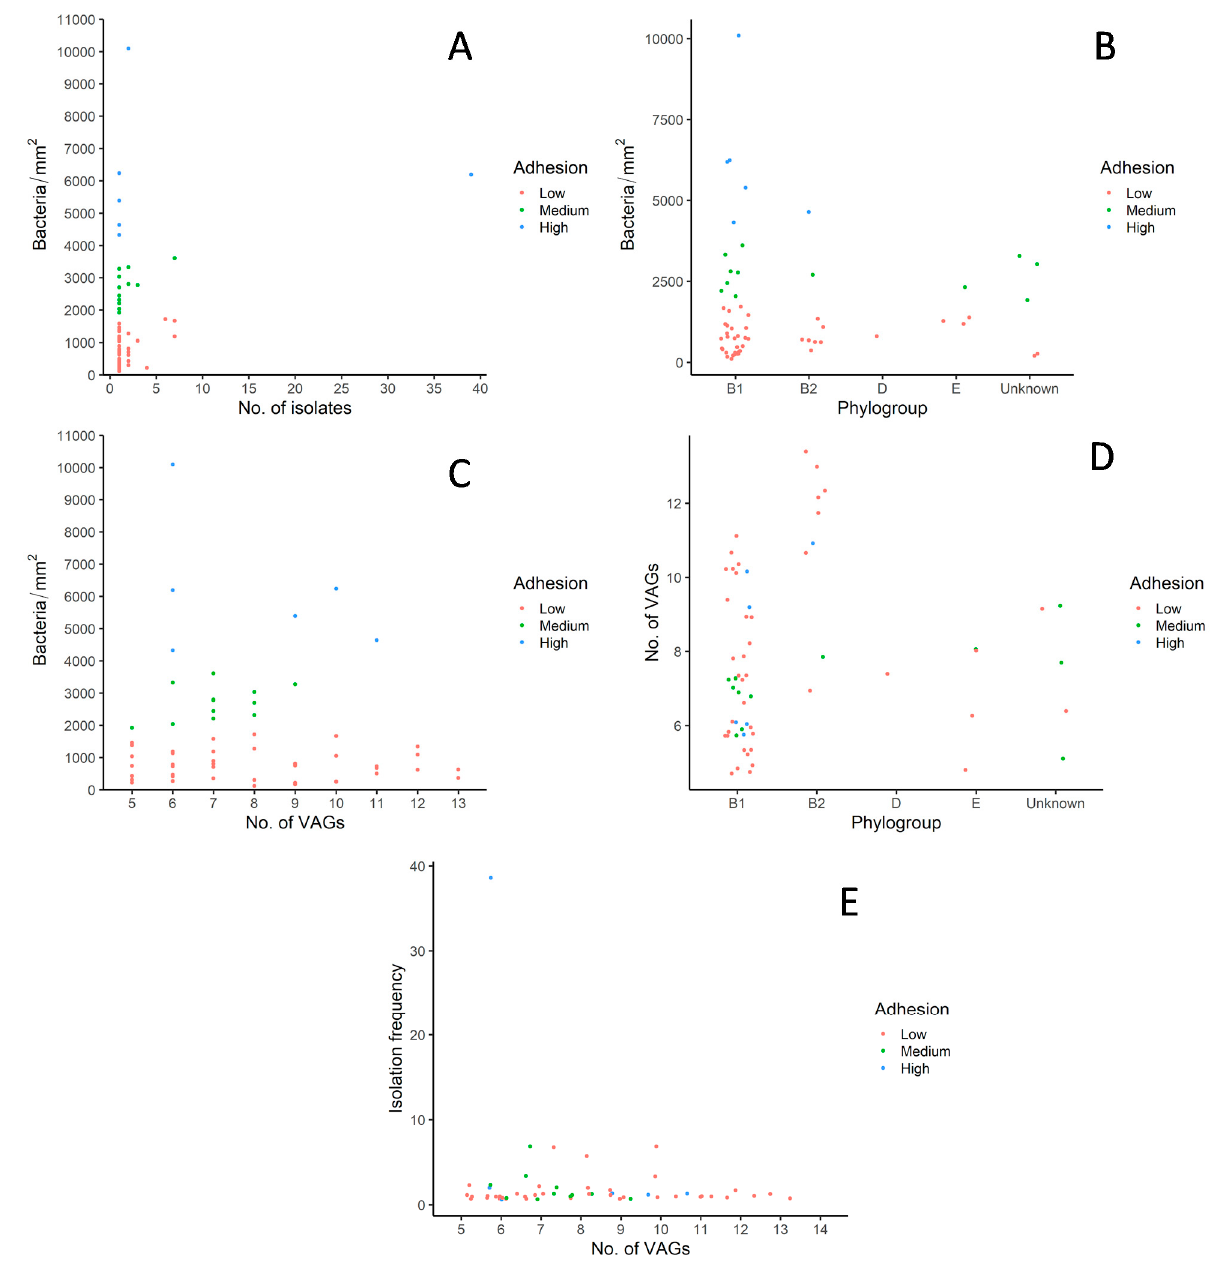
Figure 3. Correlation analysis for colonization parameters of E. coli in cormorant colony ‐ 1. ( A ) Number of isolates per pulsotype with adhesion rates; ( B ) Phylogroups with adhesion rates; ( C ) Adhesion rates with number of exVAGs; ( D ) Phylogroups with number of exVAGs; ( E ) Number of exVAGs with isolation frequency. Shown are scatterplots with one plot representing one pulsotype.